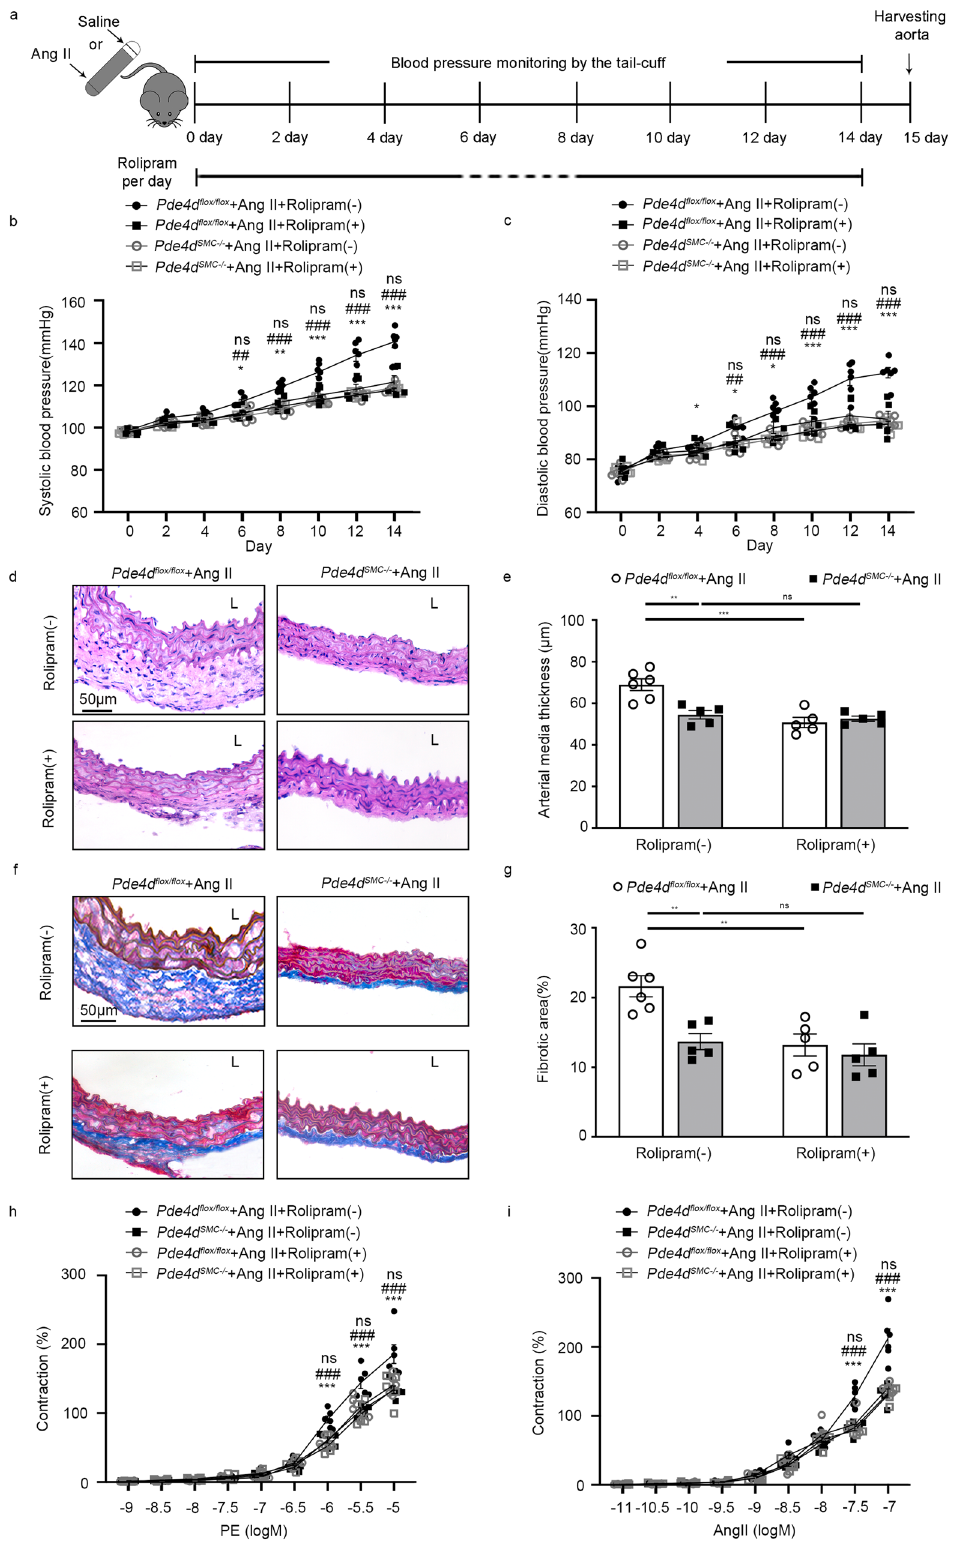
then threaded through the occlusion cuff and the sensor cuff, which was then attached to the controller. For each measurement, fi ve values of SBP and DBP were recorded for each mouse and their mean values were used as the fi nal